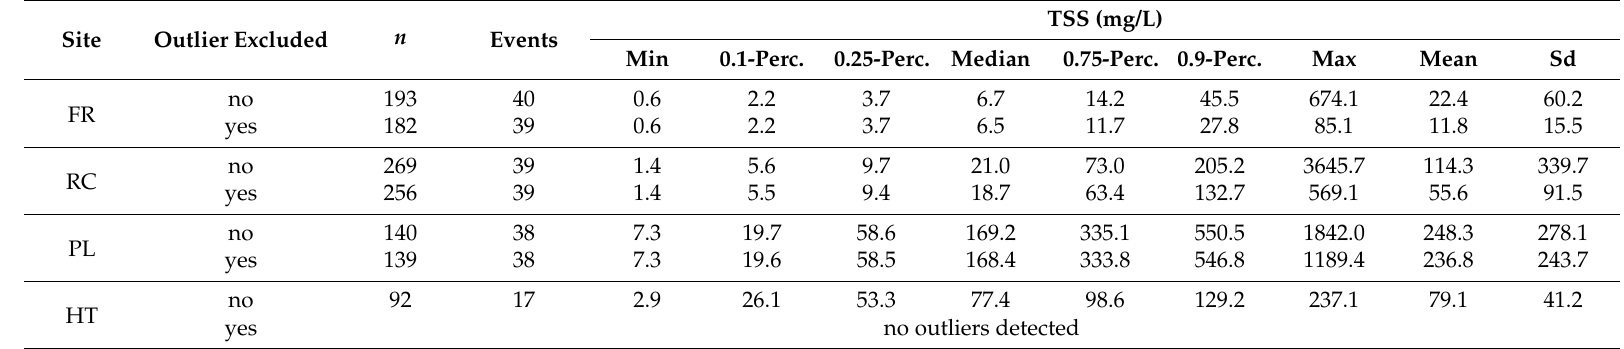
Table 1. Site-specific TSS sample